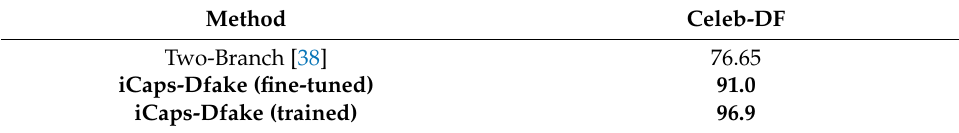
Table 6. Video-level AUC scores (%) on Celeb-DF dataset.